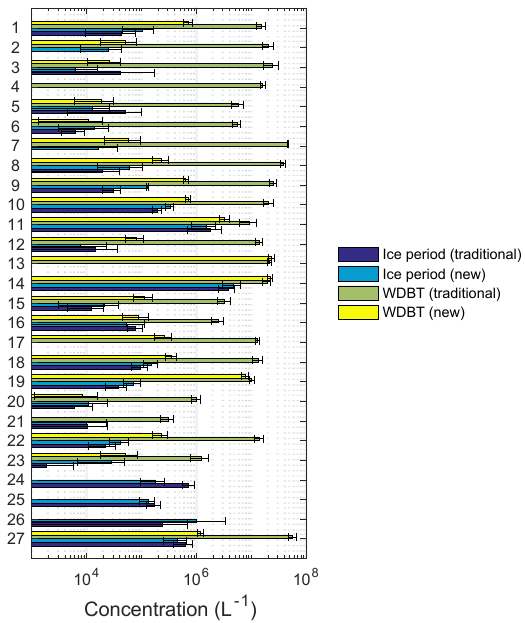
Figure 9. Individual cases of “ice-only” and “WDBT” INP concen- tration comparisons with the traditional size cut and depolarization ratio methods. Error bars report the CFDC-CASPOL counting error of